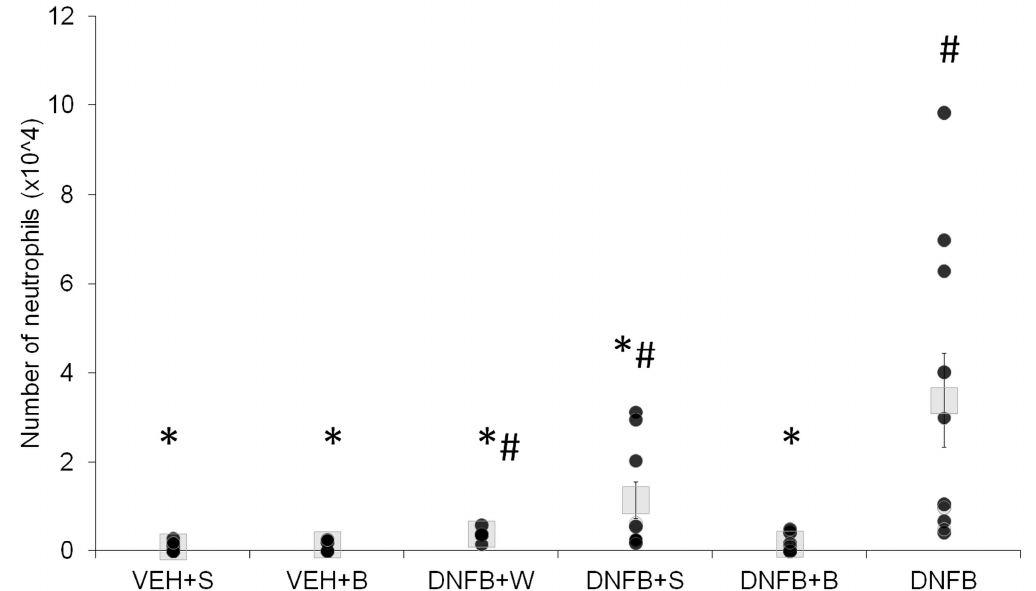
Figure 3. Total number of neutrophils per lung. # p < 0.05 vs. VEH + S (Mann–Whitney U test); * p < 0.05 vs. DNFB (Mann–Whitney U test); means ± SE, n = 6–10 VEH + S, sham-sensitized saline-inhaled; VEH + B, sham-sensitized brine-inhaled; DNFB + W, sensitized pure water inhaled; DNFB + S, sensitized saline inhaled; DNFB + B, sensitized brine inhaled; DNFB, sensitized non-inhaled.